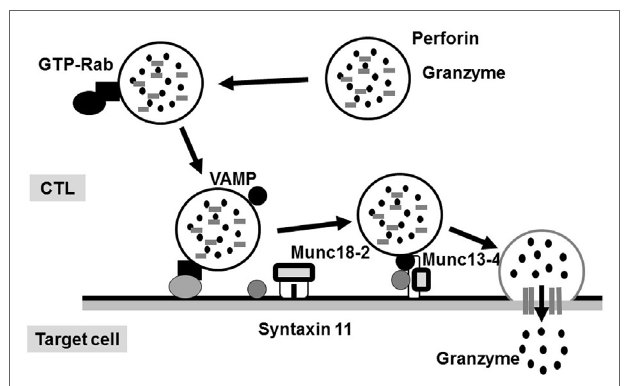
FiGURe 2 | Secretion of lytic granules in NK/CTL . After stimulating target cells, CTL organizes the immunological synapse. Rab27a promotes the transporting and docking of lytic granules at the immunological synapse along with Munc13-4. Interactions between Munc18-2 and SNARE (such as syntaxin 11) allow lytic granules to reach the synapse, where granule secretion occurs.